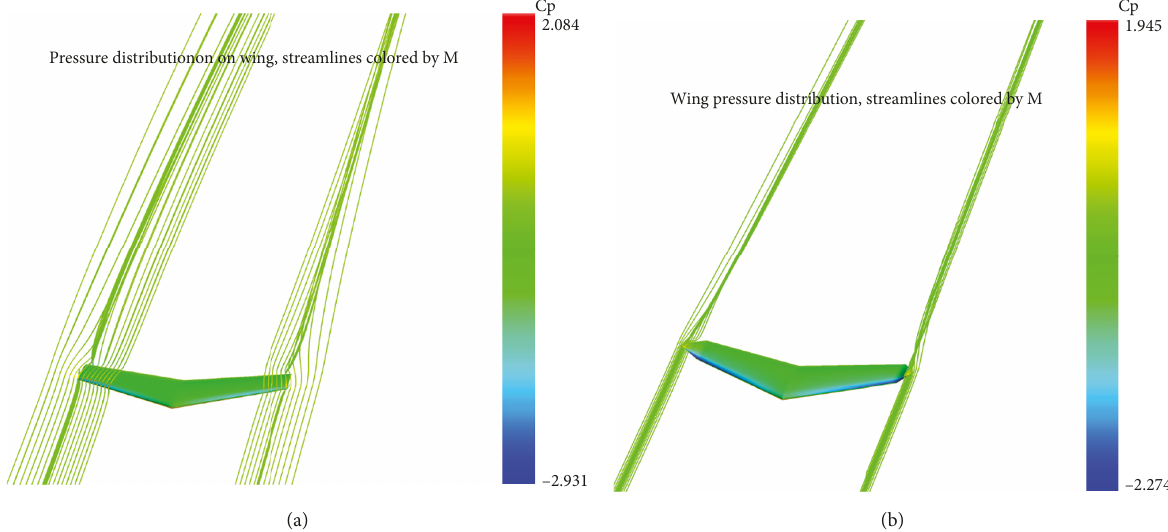
Figure 11: Plain BGK wing (a) and with folding tips (b) under no side wind shear.